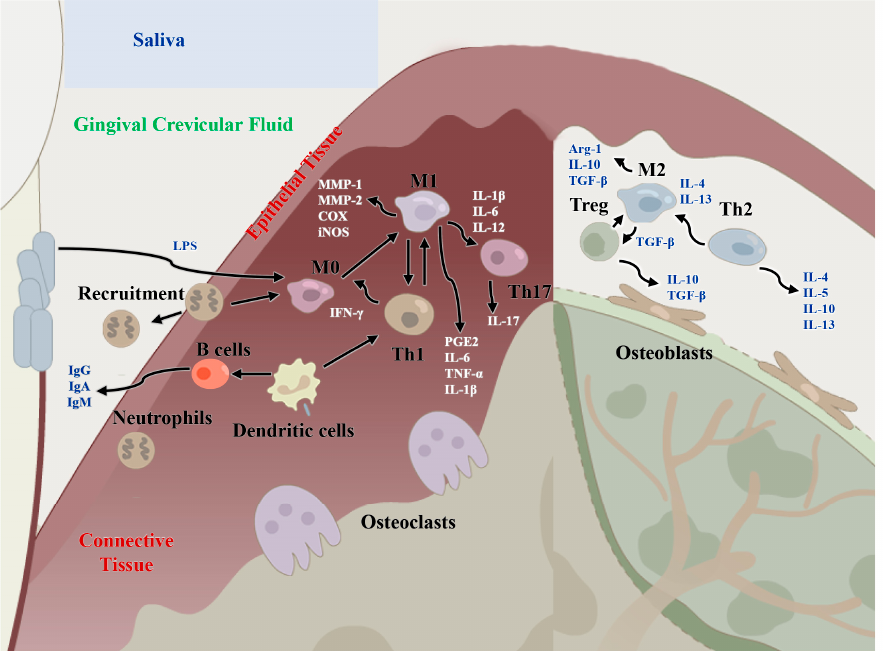
Figure 2. Regulatory functions of immune cells of the host immune microenvironment in periodontitis and periodontal bone remodeling. M1: classical macrophages; M2: nonclassical macrophages; Th1: T helper cell 1; Th2: T helper cell 2; Th17: T helper cell 17; MMP-1/2: matrix metalloproteinase 1/2; IL-: interleukin-, IFN- γ : interferon gamma; TNF- α : tumor necrosis factor alpha; TGF- β : transforming growth factor beta; Arg1: Arginase-1; PGE2: prostaglandin E2; COX: cyclooxygenase.